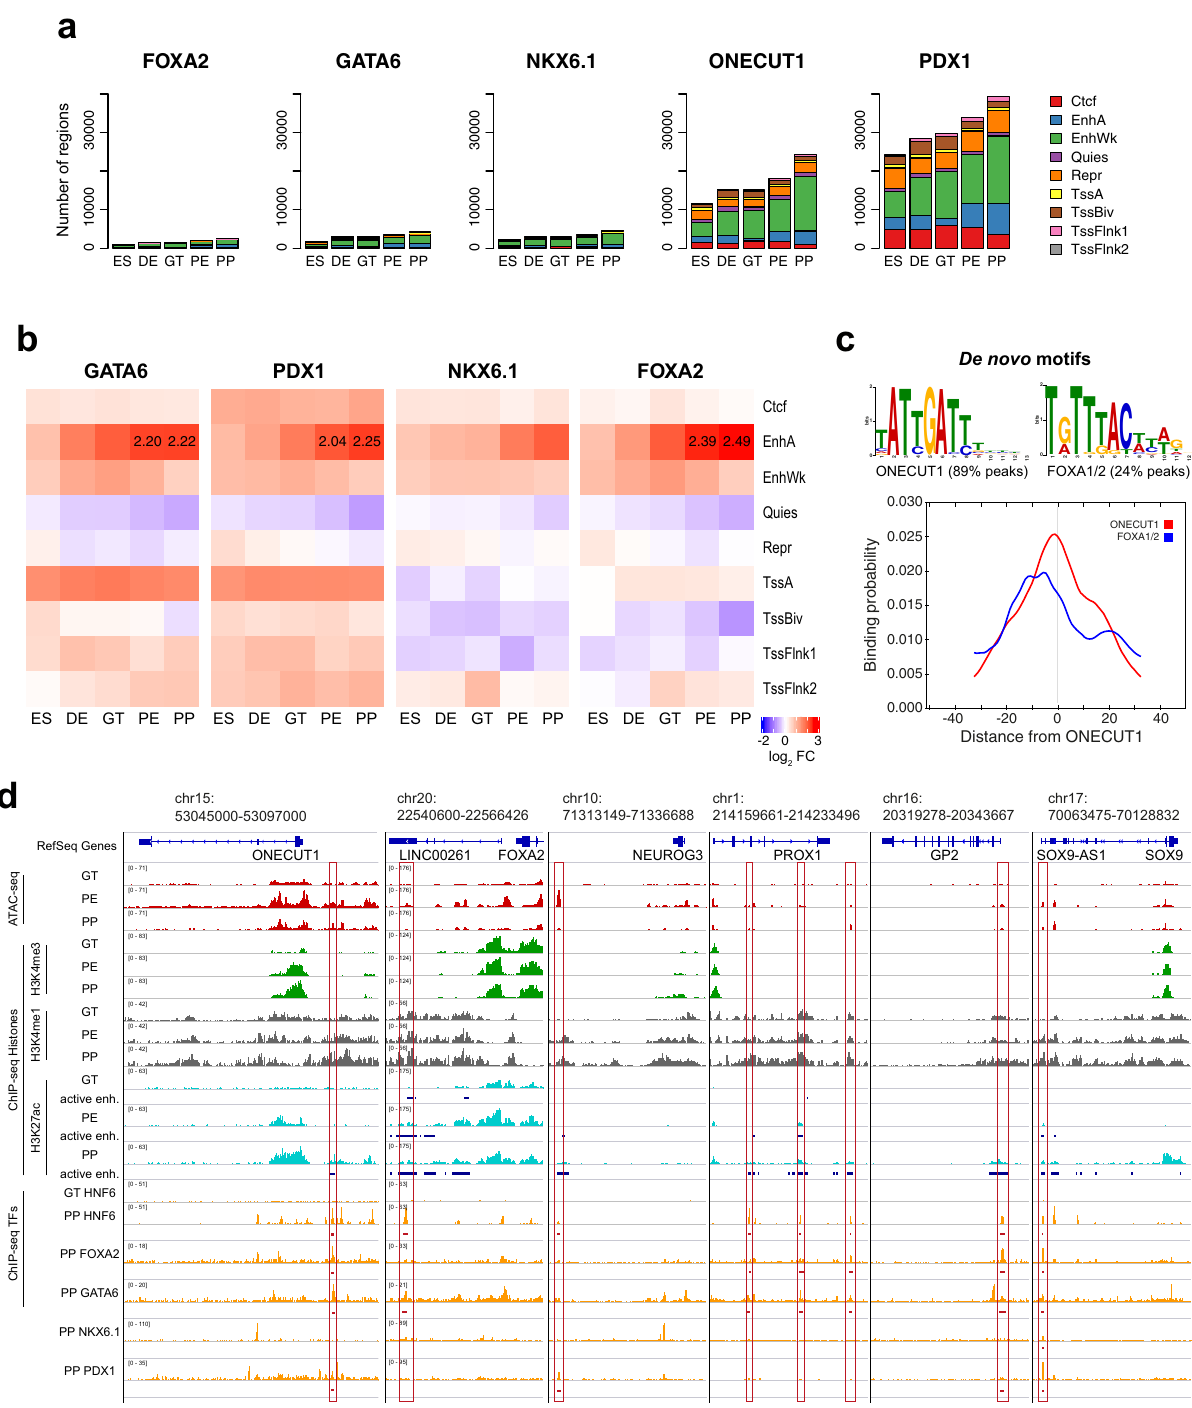
Fig. 4 ONECUT1 cobinding during early pancreas differentiation regulation. a Overlap of peaks of distinct TFs on chromatin states as delineated by chromHMM. These states include active enhancers (EnhA), weak/poised enhancers (EnhWk.), repressed regions (Repr.), active promoters (TssA), poised promoters (TssBiv) and regions fl anking active promoters (TssFlnk1-2). b Log2 fold change (FC) of the frequency of ONECUT1 co-binding events (ONECUT1 with either GATA6, PDX1, NKX6.1, and FOXA2) vs. ONECUT1 exclusive binding sites for distinct chromatin states and differentiation stages. Red values indicate chromatin stages over-represented in co-binding events. We highlight values with abs(log2(FC)) > 2. c We show MEME de novo motifs around ONECUT1 ChIP-seq peaks, which are found in 89% of peaks, and FOXA2 motif, which is found in 24% of peaks. Both motifs have a preference relative to the peak center, i.e., ONECUT1 is mostly localized in the peak middle, while FOXA2 is located 9 – 10 bps downstream of peak center. d IGV Genome browser view of ONECUT1 and PE/PP expressed genes with ChIP-seq and ATAC-seq pro fi les from GT, PE, and PP stages. We highlight ONECUT1 peaks overlapping with active enhancers (blue tracks below H3K27ac tracks) gained at PE or PP stage, as well as co-binding partners.